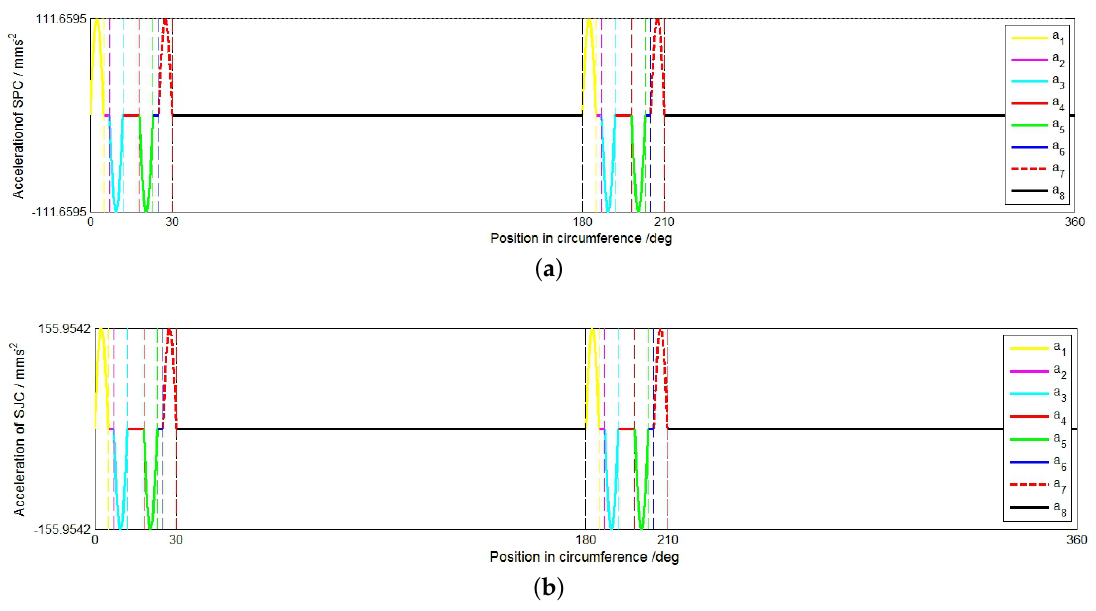
Figure 8. The velocity of SPC pushed by SJF. ( a ) The acceleration of SPF pushed by SPC. ( b ) The acceleration of SJC pushed by